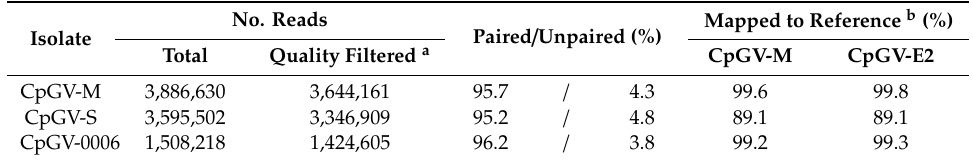
Table 1. Result of the genome sequencing of isolates CpGV-M, CpGV-S and CpGV-0006 using short-read Illumina sequencing. Paired-end reads were 151 bp long.